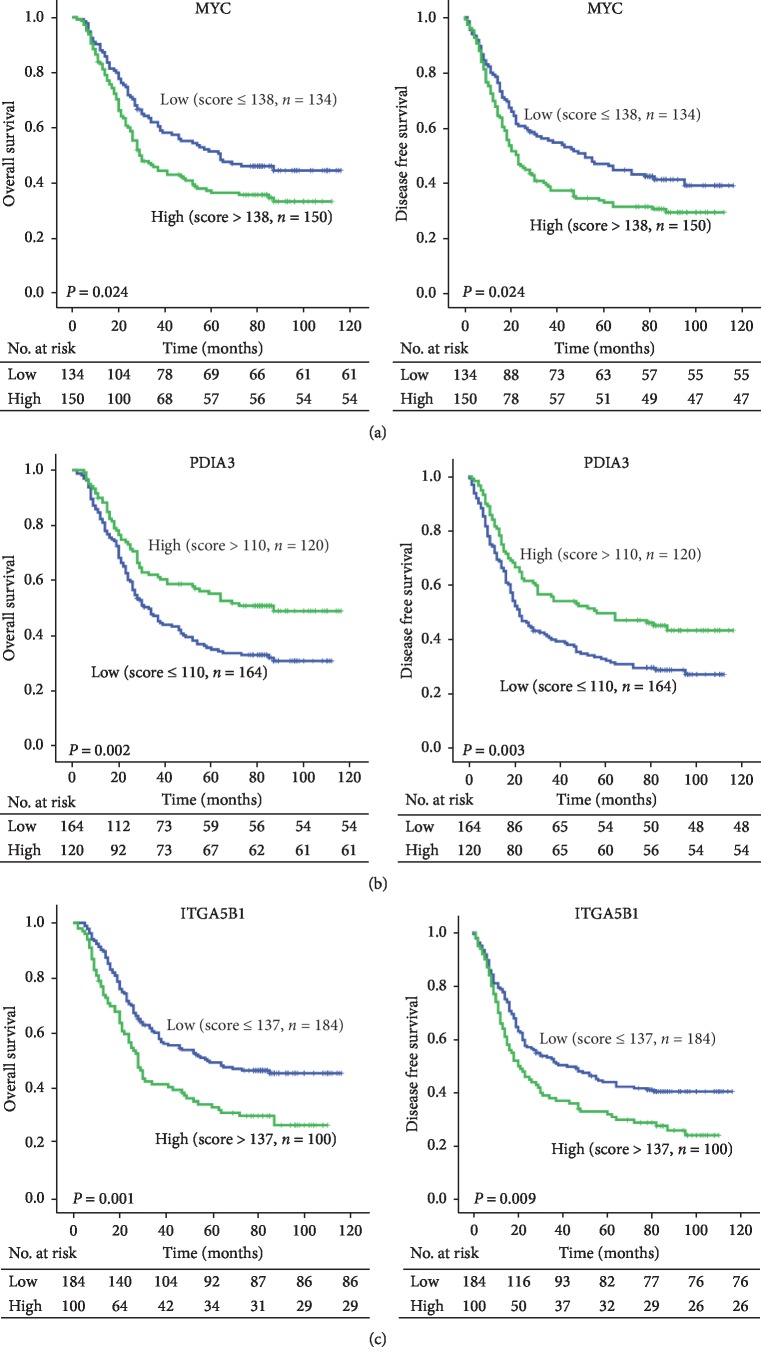
K-M survival analysis in ESCC patients based on the expression of MYC, PDIA3, and ITGA5B1. The H scores of each protein were divided into low and high groups as determined by X-tile, and the number of patients who were at risk at specific times was labeled under the x-axis (P < 0.05, log-rank test).